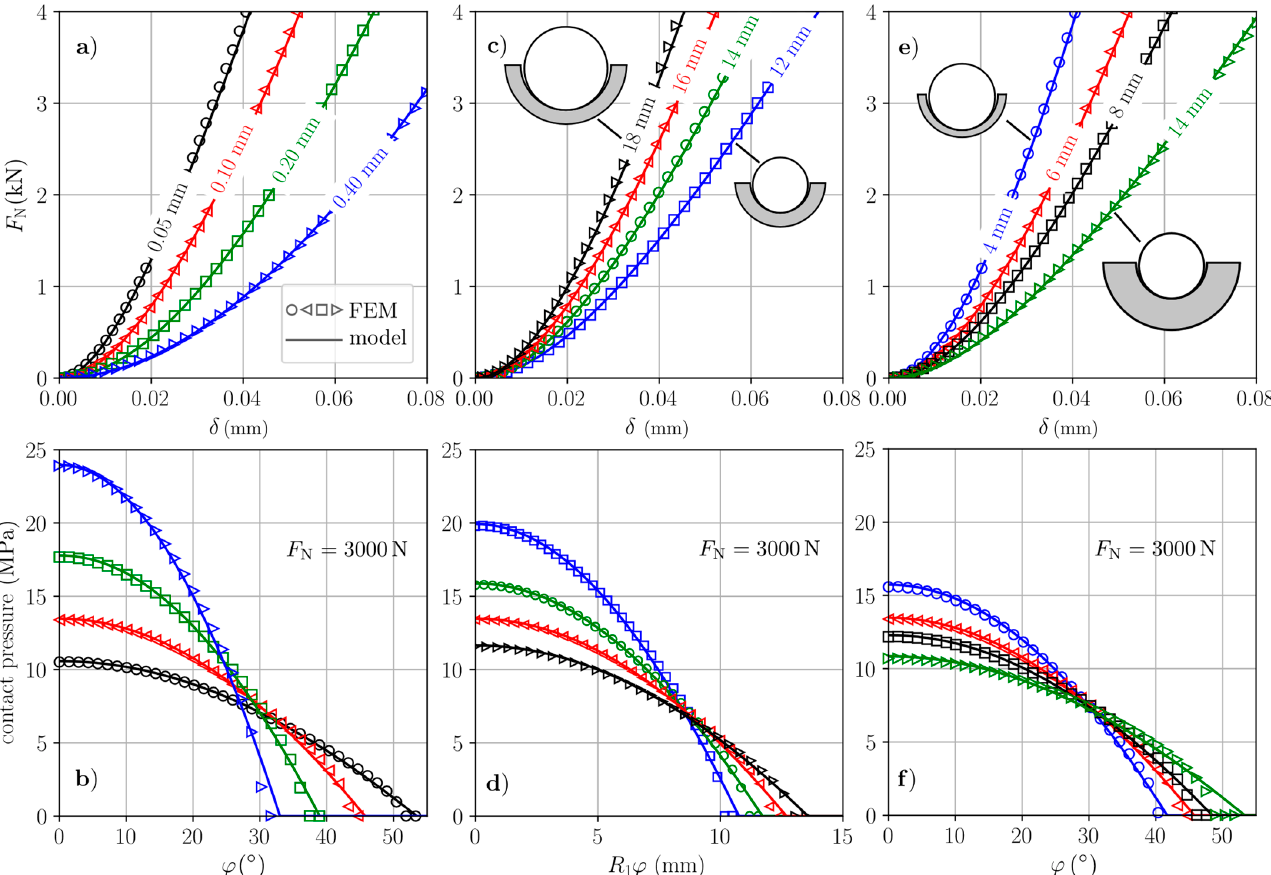
Figure 5. Comparison of the normal force F N against normal displacement δ and contact pressure against angular coordinate ϕ or half arc length R 1 ϕ relations between FEM solution and analytical model. ( a , b ) different radial clearances ∆ R with R 1 = 16 mm and L = 6 mm, ( c , d ) different head radii R 1 with ∆ R = 0.1mm and L = 6 mm, and ( e , f ) different liner thicknesses L with ∆ R = 0.1 mm and R 1 = 16